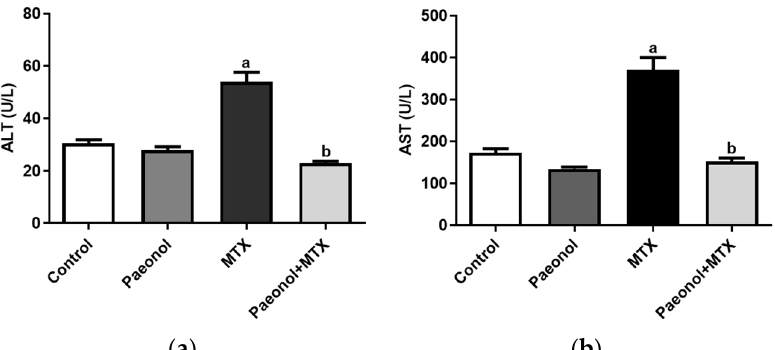
Figure 1. The effect of paeonol on the serum ( a ) alanine transaminase (ALT) and ( b ) aspartate transaminase (AST) in methotrexate (MTX)-induced hepatotoxicity in rats. Data are represented as mean ± SEM ( n = 6). Letters a,b Denote significant differences from the normal control and the MTX groups, respectively, at p <